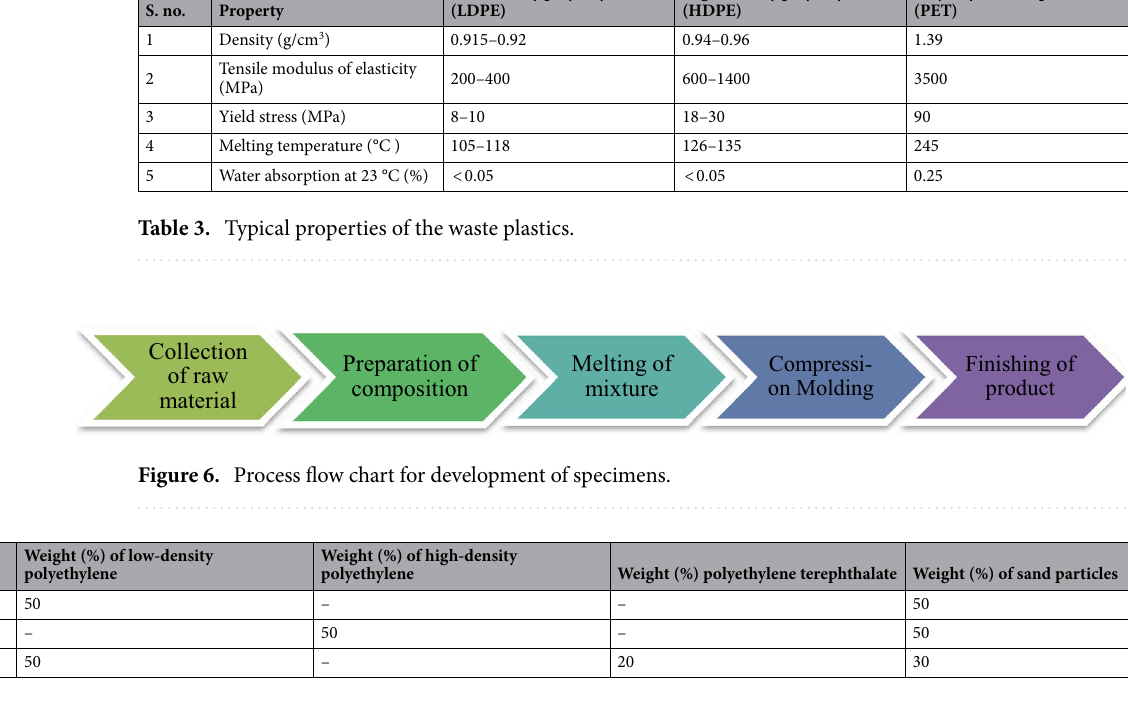
Table 4. Compositions of